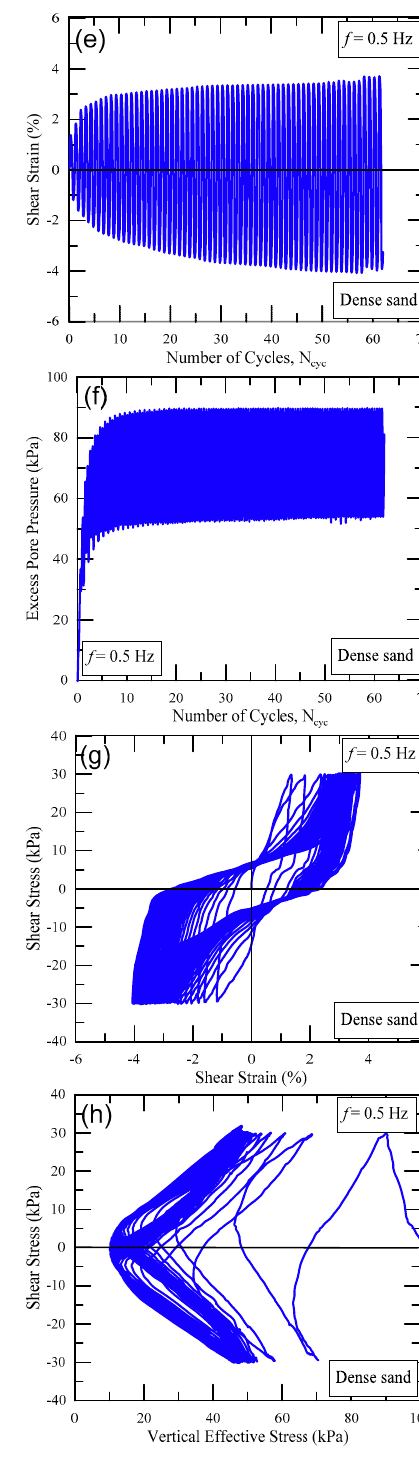
Figure 5. Undrained response of dense sand at σ v0 (cid:48) = 100 kPa and CSR = 0.3: ( a – d ) f = 0.05; ( e – h ) f =